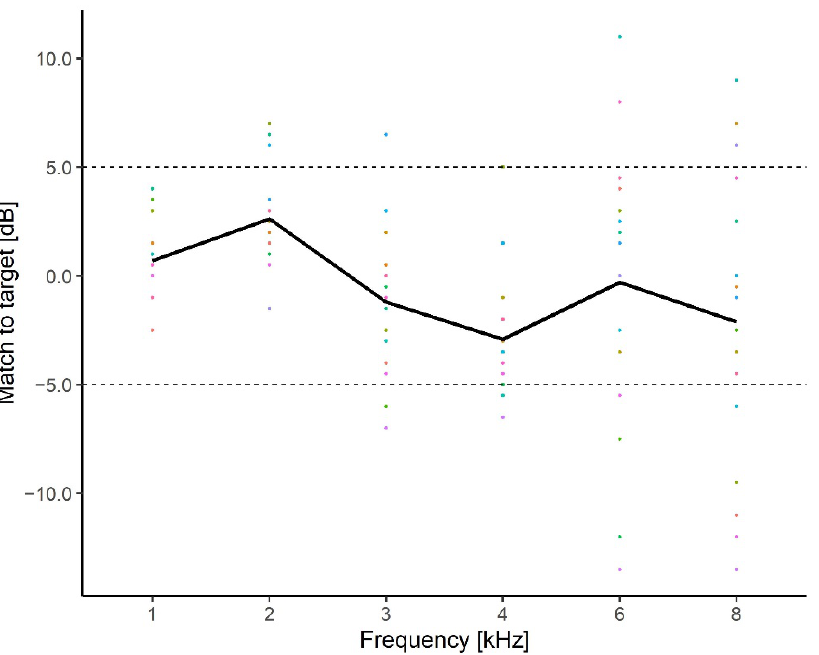
Figure 8. Difference between REIG and the target gains provided by the hearing aid fitting software. The average of the left and right ears is shown. Individual participant data (colored lines) and the average (black line) across participants are shown. The dotted lines represent the +/ − 5 dB tolerance recommended at frequencies between 250 Hz and 6 kHz when comparing the REIG to the target value (BSA